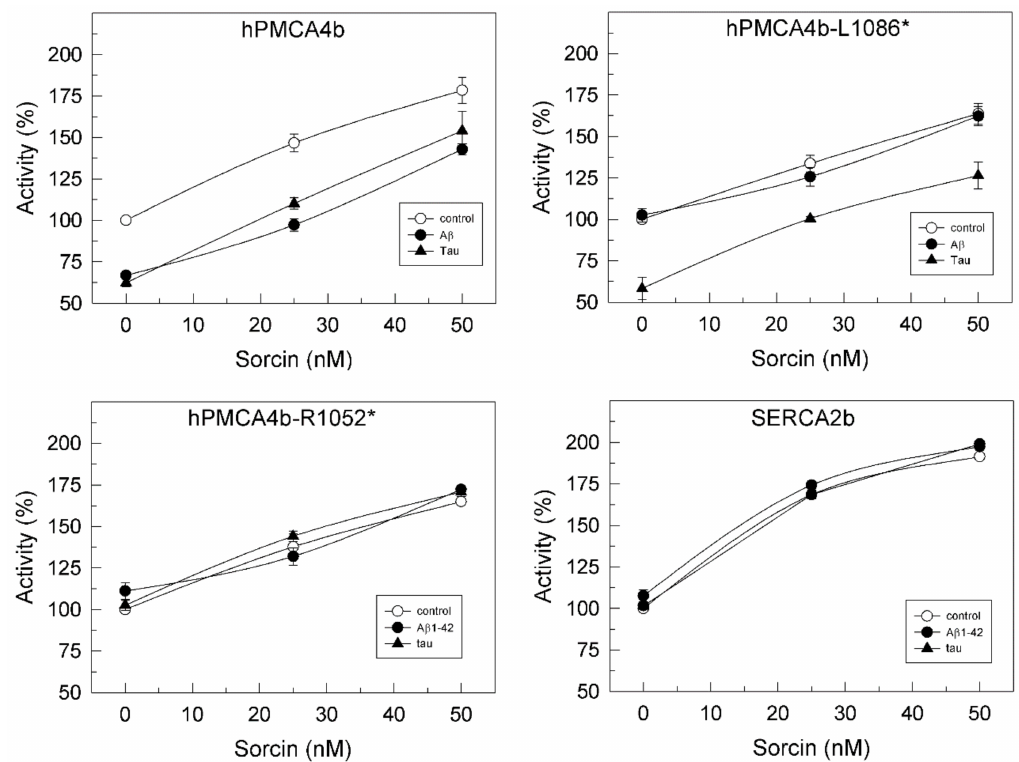
Figure 4. Sorcin activates Ca 2+ -ATPase activities of overexpressed full hPMCA4b, their truncated variants and SERCA2b isoforms in a concentration-dependent manner and prevents their inhibition by A β and tau. Twenty µ g of COS cells’ membranes overexpressing full hPMCA4b, or truncated hPMCA4b-L1086* and hPMCA4b-R1052* and SERCA2b isoforms were treated with increasing concentrations of sorcin, without ( ) or with 30 µ M A β 1-42 ( • ) or 300 nM tau ( (cid:78) ), in 25 µ L, (cid:35) and then diluted up to 1 mL with the assay medium plus 0.01% saponin, resulting in the indicated final concentrations of sorcin. Activities were measured as indicated in the Methods Section, after addition of 1 mM ATP. The 100% activities correspond to 0.226 ± 0.02, 0.235 ± 0.03, 0.242 ± 0.02 and 0.190 ± 0.003 µ mol. min − 1 . mg − 1 for hPMCA4b, hPMCA- L1086*, hPMCA-L1052* and SERCA2b, respectively. Data represent mean ± SE of three experiments performed with three